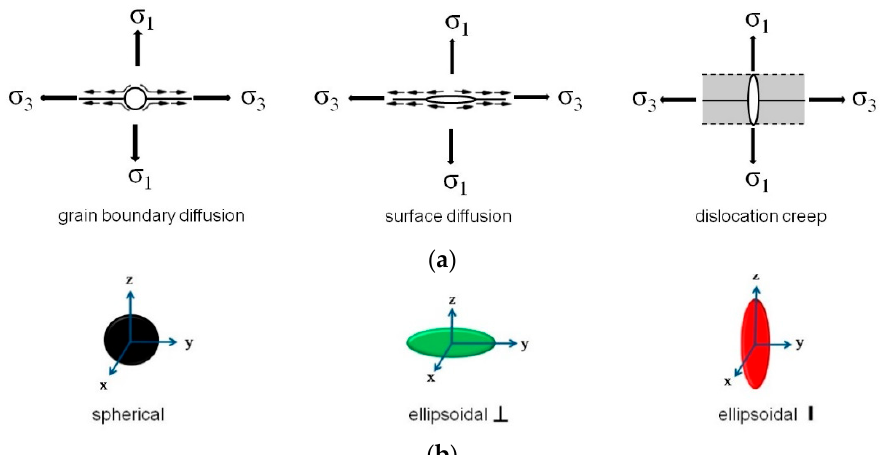
Figure 2. ( a ) Creep mechanisms and ( b ) the related void morphologies.